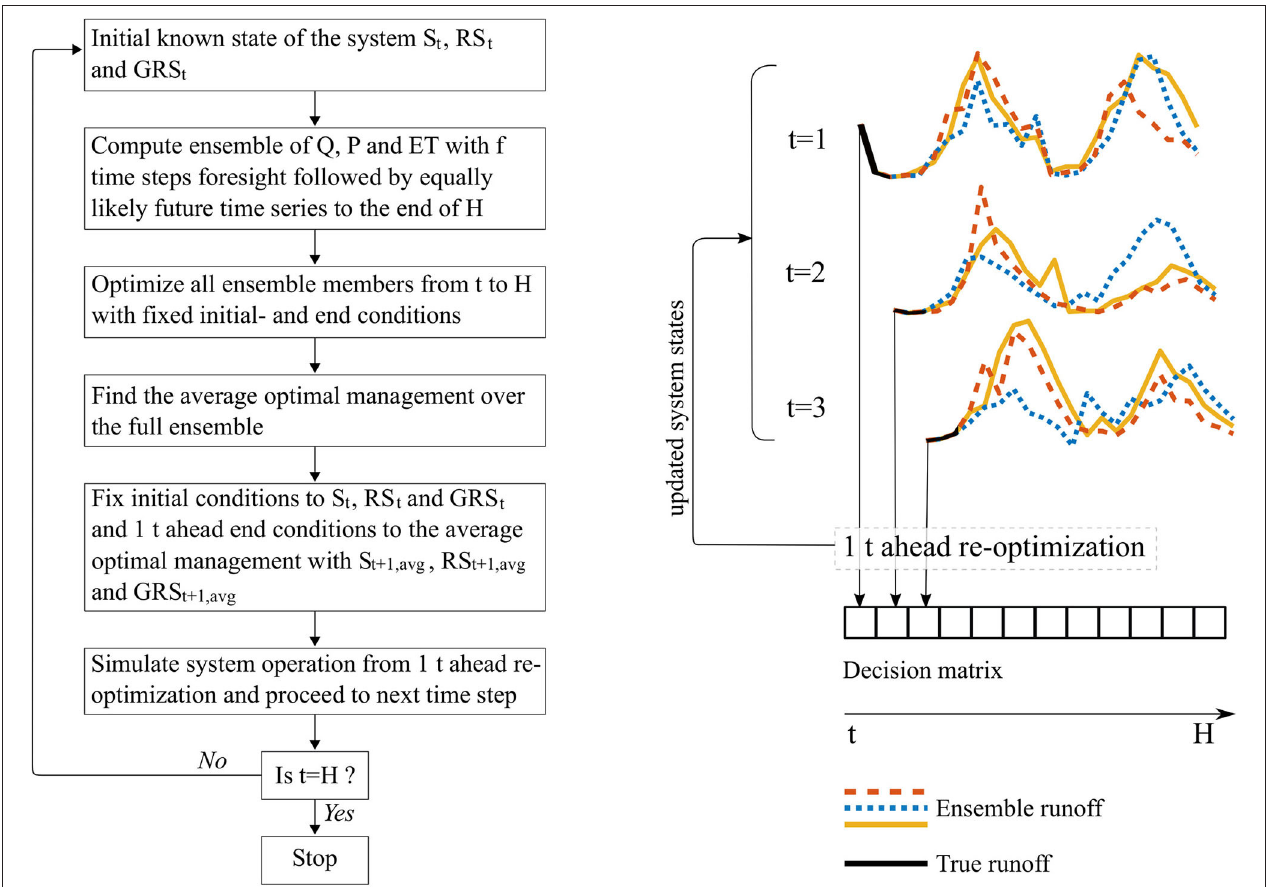
FIGURE 6 | Flowchart and visual illustration of the MPC routine. The visual illustration illustrates a 1-month (1f) foresight horizon.